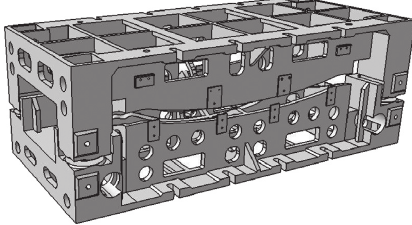
Figure 3: Trunk trim panel mold formwork.